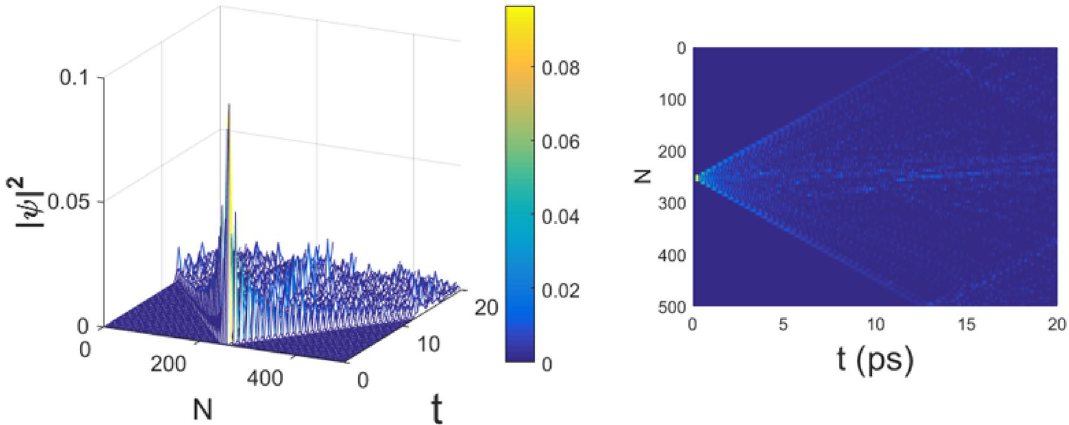
500 amino acids. =